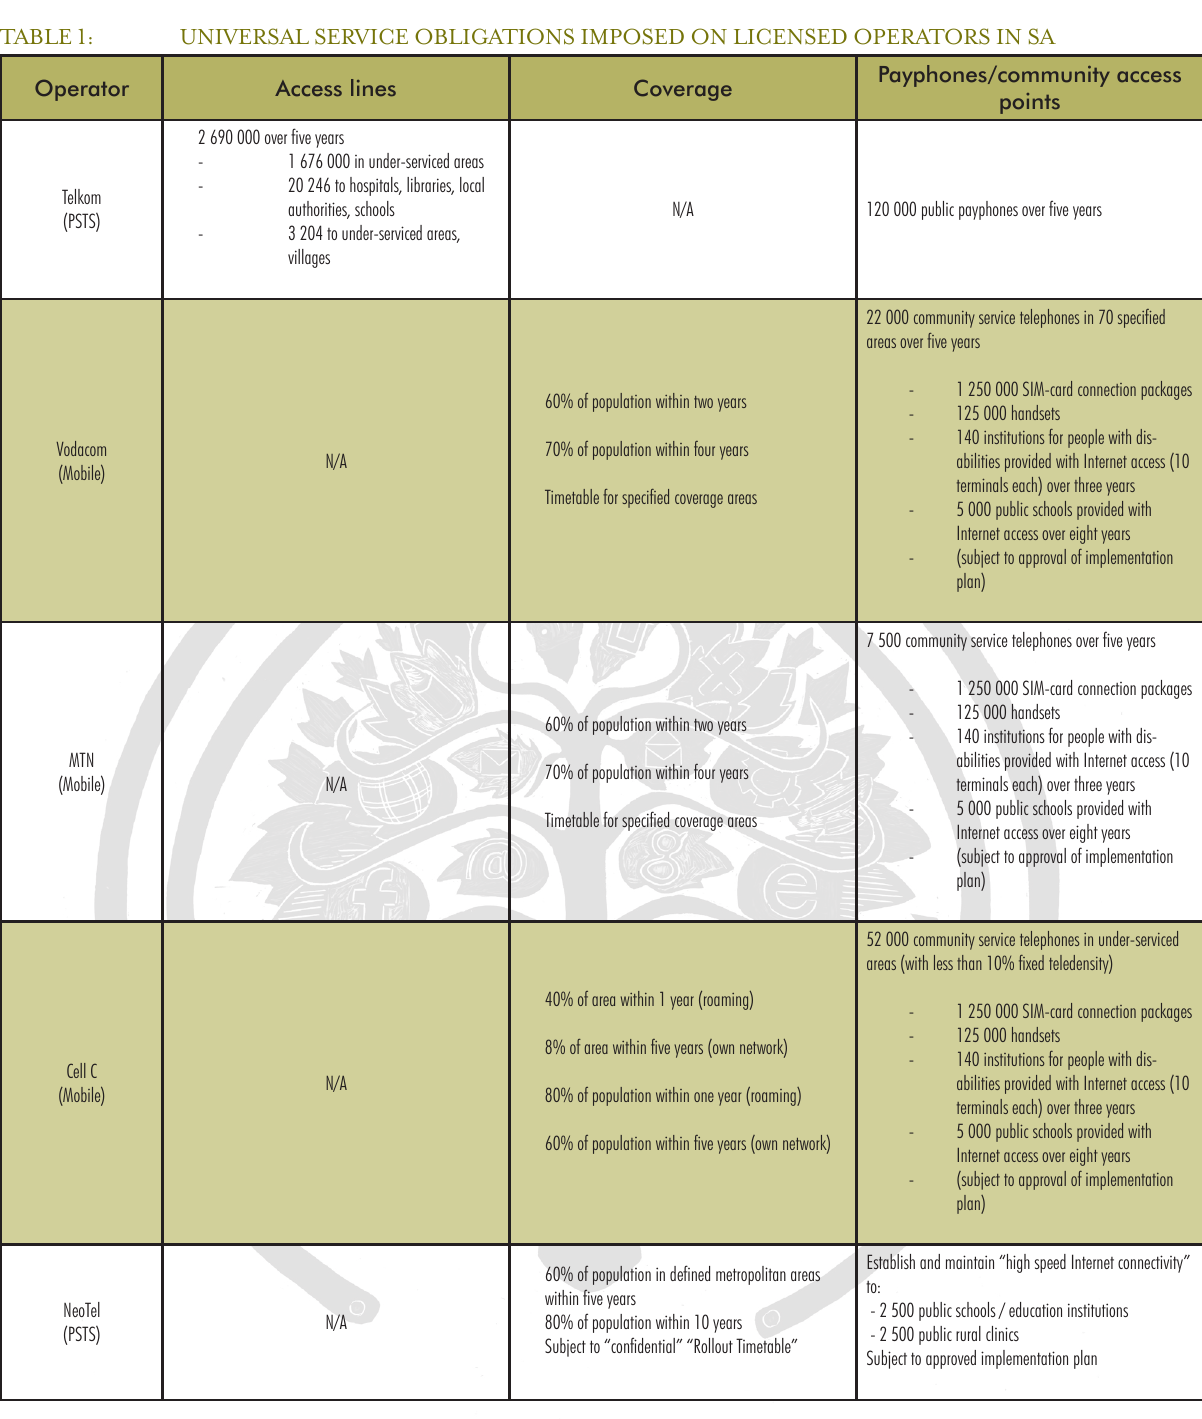
TABLE 1: UNIVERSAL SERVICE OBLIGATIONS IMPOSED ON LICENSED OPERATORS IN SA Operator Access lines Coverage